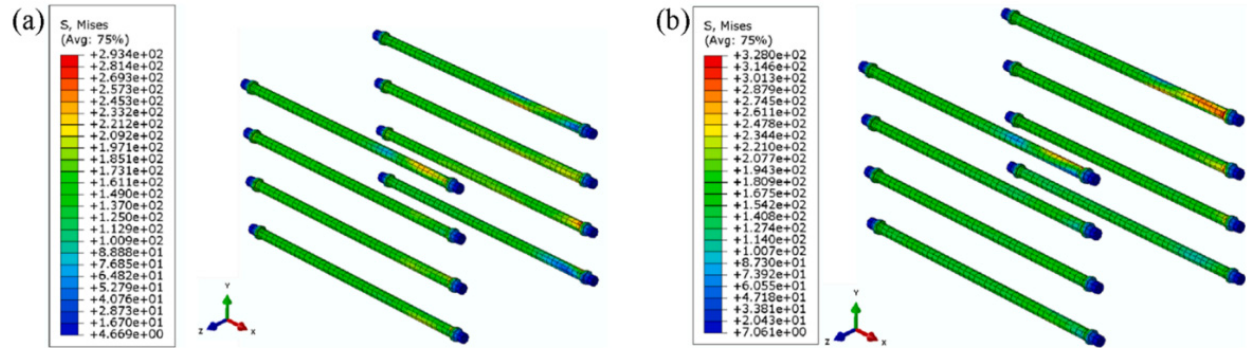
Figure 29. Stress cloud images of the bolts (failure state): ( a ) J1, ( b )